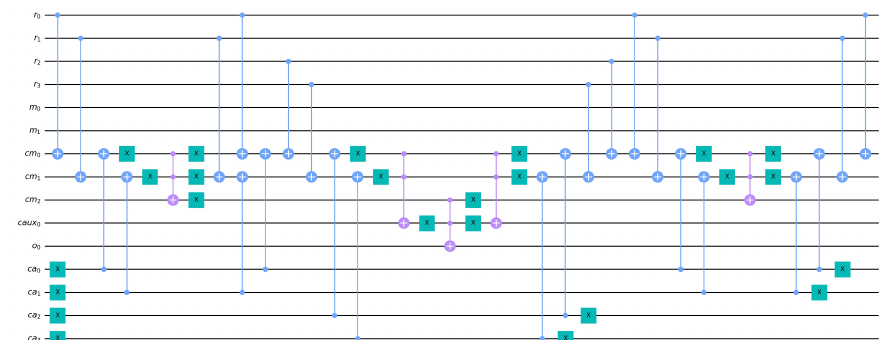
Figure 18. Circuit for expression (24) to validate the movements, if the output o is marked, an impos- sible movement has been detected. Similarly to the circuit of Figure 17, some sections of this operator uncompute the qubits, freeing up auxiliary qubits that have accomplished their objective and can be reused to perform other computations.